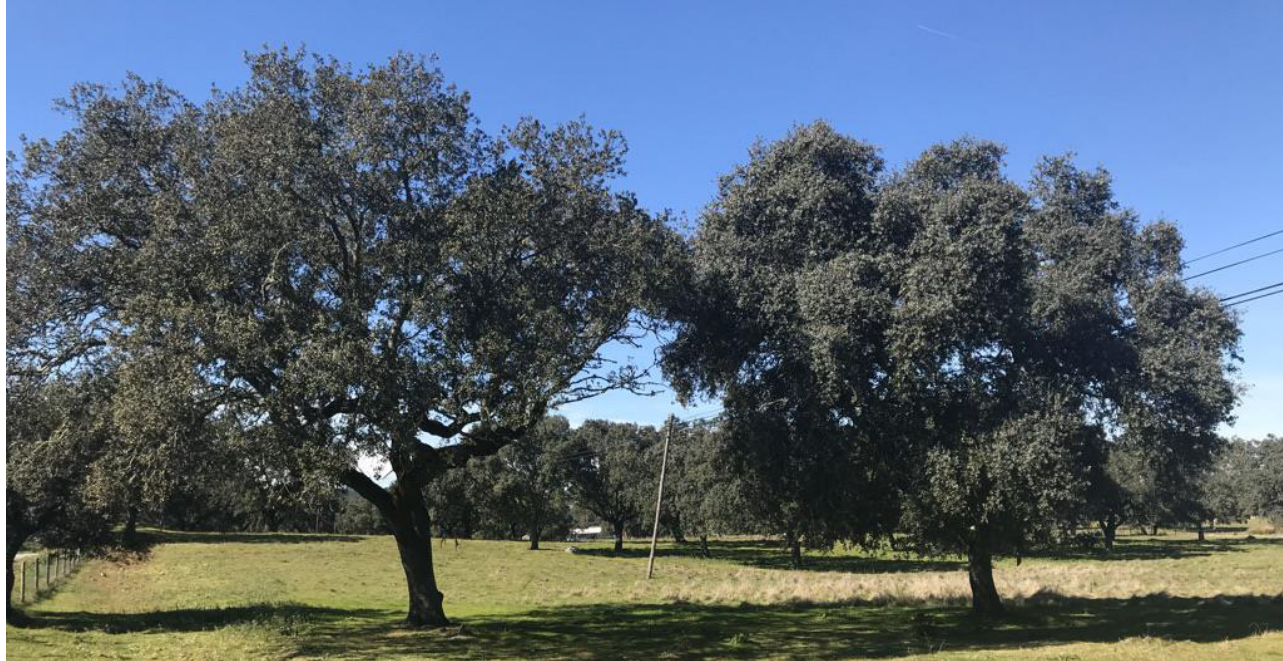
Figure 5. “Montado” landscape in Southern Portugal, in the region of Alentejo with a forest of Quercus suber .